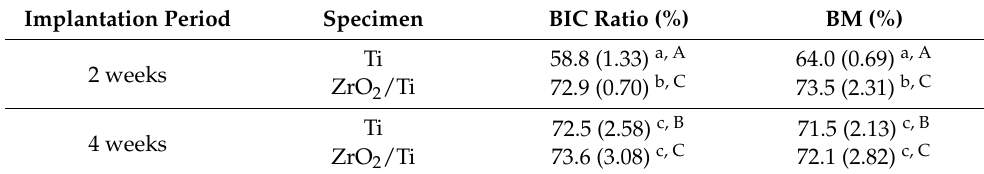
Table 3. Percentage of BIC ratio and BM